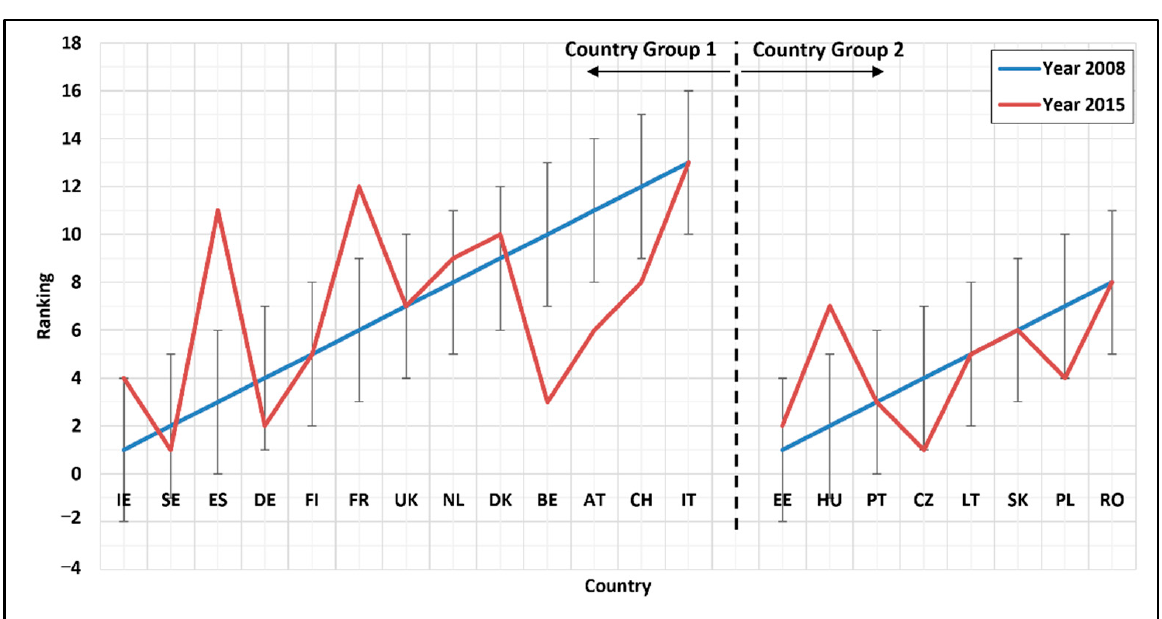
Figure 4. The change in each country’s respective ranking based on the index score between 2008 and 2015.